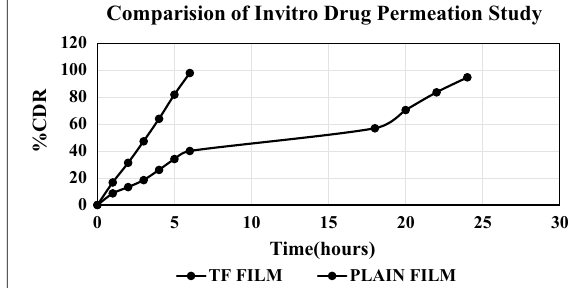
Table 7 Optimized batch formulation Optimized batch no.